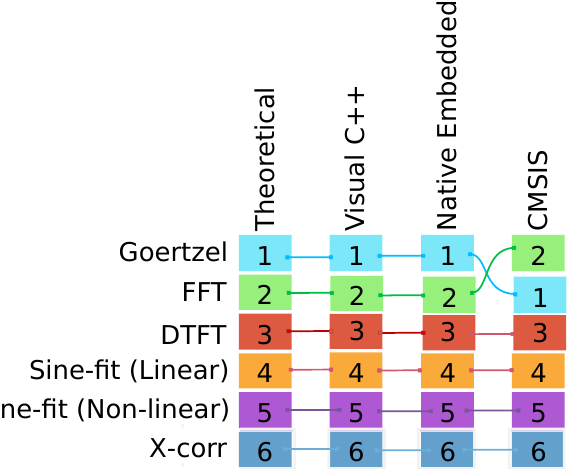
Figure 6. Bump Chart of the AC signal analysis Methods Ordered by their speed in the Different Im- plementations.